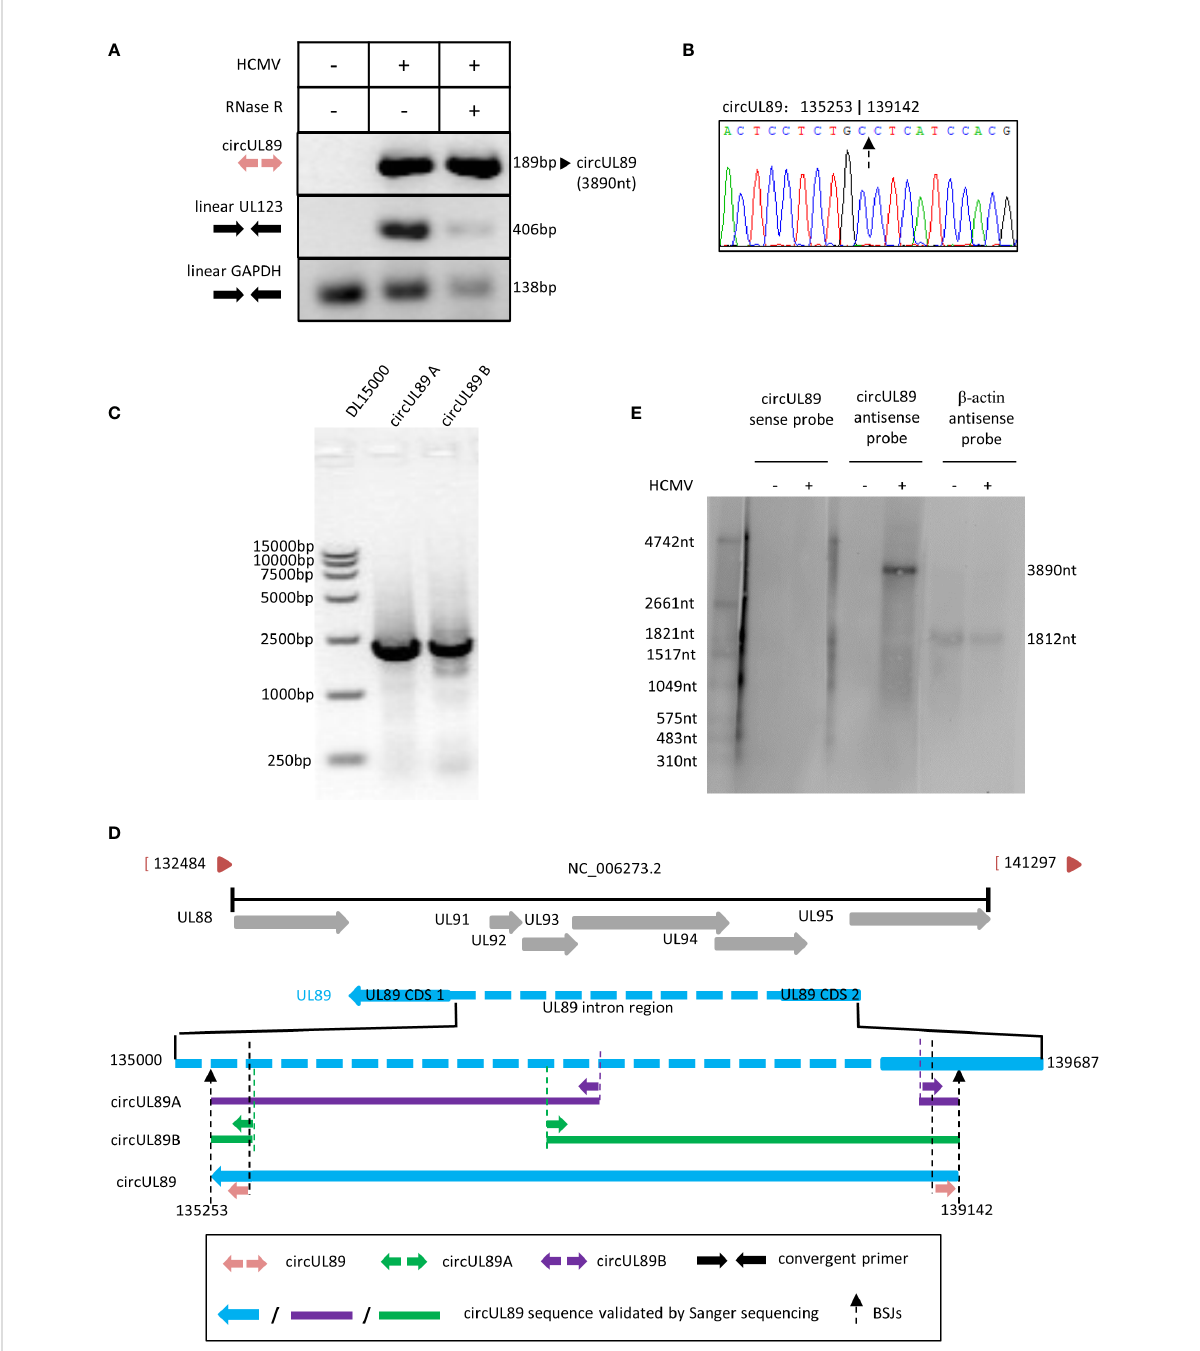
FIGURE 5 Validation and characterization of HCMV circUL89. (A) Inverse RT-PCR products of circUL55 with BSJs validation primer set in Figure 1. A 189 bp band was achieved as antipicated. Linear GAPDH and linear UL123 were ampli fi ed as RNase R-resistant control. (B) Sanger sequencing result of circUL89 BSJ. (C) Inverse RT-PCR results of HCMV circUL89 fragments A and B with divergent outer primer sets indicated in Figure 1. Both of the two fragments, which were overlapped in two terminals, were about 2000 bp in size. The whole sequence of circUL89 was achieved by sequencing and splicing. (D) The circUL89 full sequence mapping to HCMV UL89 gene. (E) Northern blot of